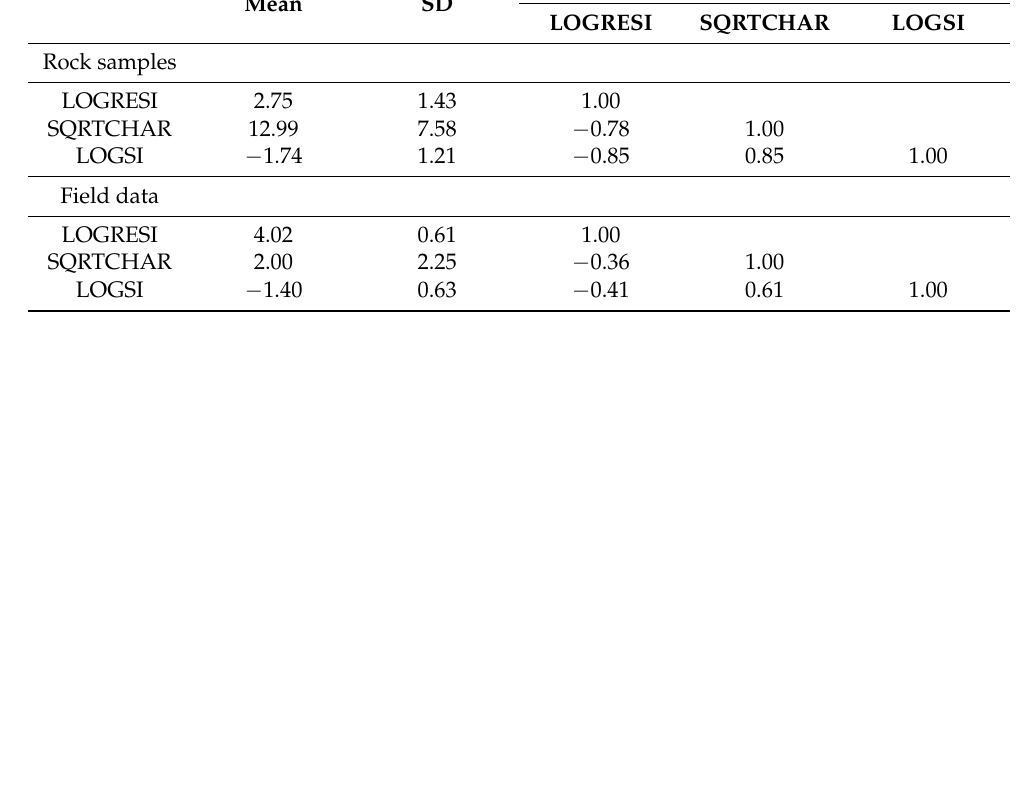
Table 4. Correlation, mean and standard deviation (SD) of values of transformed electrical resistivity, chargeability, and magnetic susceptibility for drilling cores and field observations. Mean SD